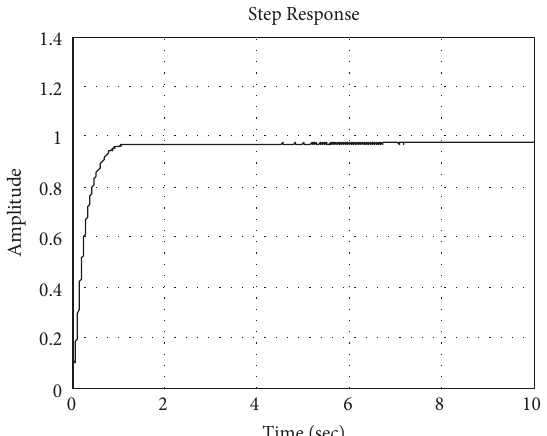
Figure 33: Response curve at 10 times β